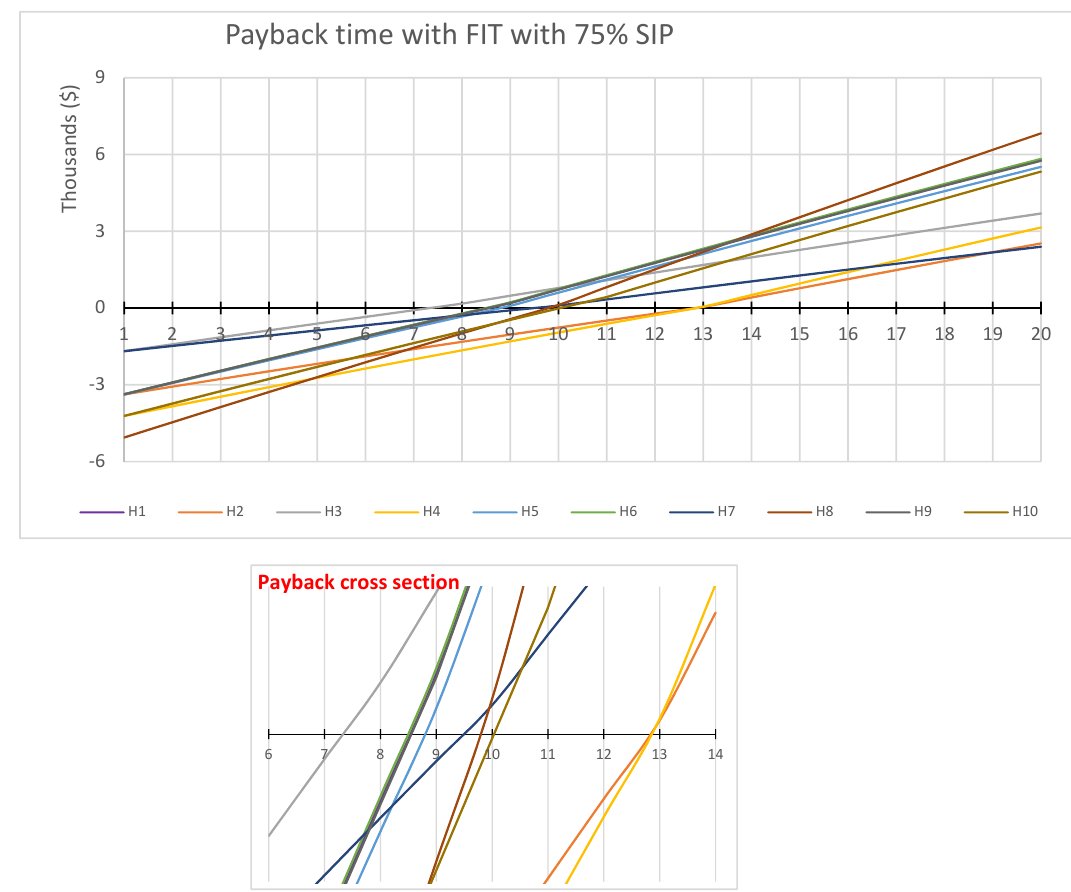
Figure 7. Economic model results demonstrate the payback time for the rooftop PV systems with FIT with 75% SIP for houses H1:H10. Table 6. Economic model results demonstrate the economic analysis for the rooftop PV systems